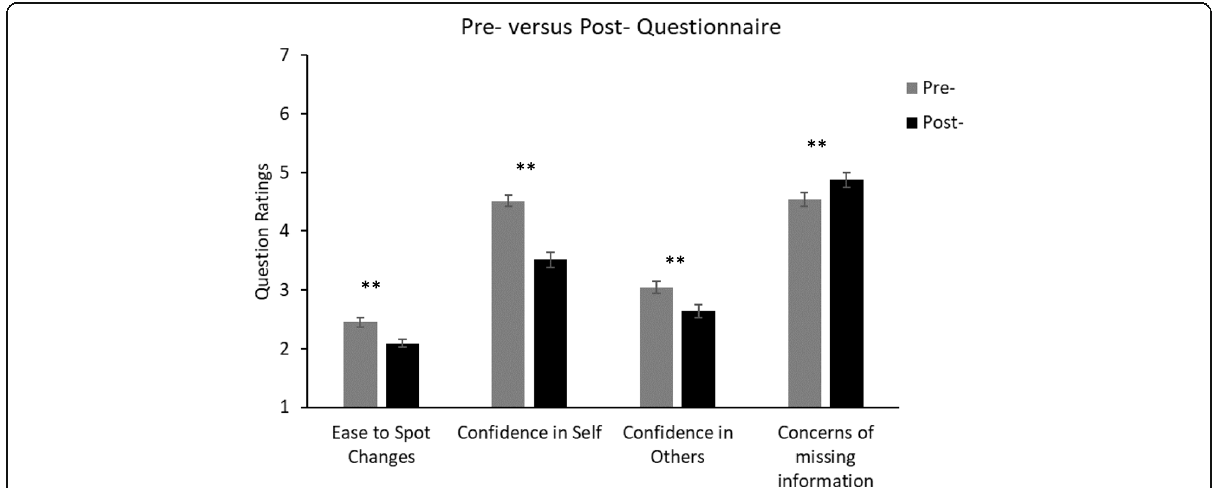
Fig. 2 Average ratings from the pre-demonstration and post-demonstration questionnaires of Experiment 1. For the “ ease to spot changes ” question, the rating scale ranged from 1 (very difficult) to 5 (very easy). For the other questions, the rating scales ranged from 1 (not at all confident/concerned) to 7 (totally confident/concerned). Significant difference: ** p < 0.01. Error bars represent the standard error. See Additional file 1 for the full